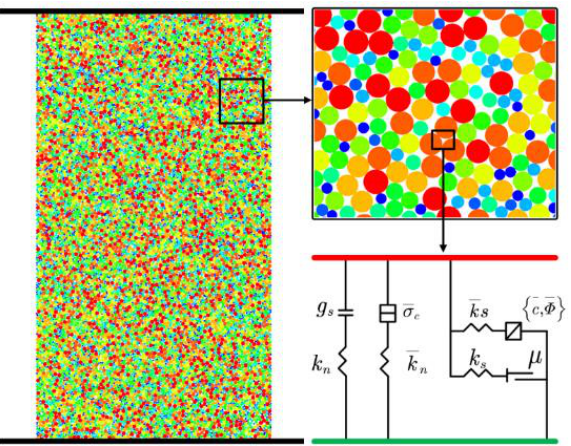
Figure 4. The diagram of the parallel bond model. 𝑔 𝑠 is the surface gap between particles and 𝑘 𝑛 is the normal stiffness of a linear spring. 𝑘 𝑠 is the shear stiffness of a linear spring, and 𝑘̅ 𝑛 is the normal stiffness of the parallel bond. 𝑘̅ 𝑠 and 𝜎̅ 𝑐 are the shear stiffness and the normal strength of the parallel bonds. {𝑐̅, 𝜙̅} is the shear strength of the parallel bond and 𝜇 is the coefficient of fric- tion.